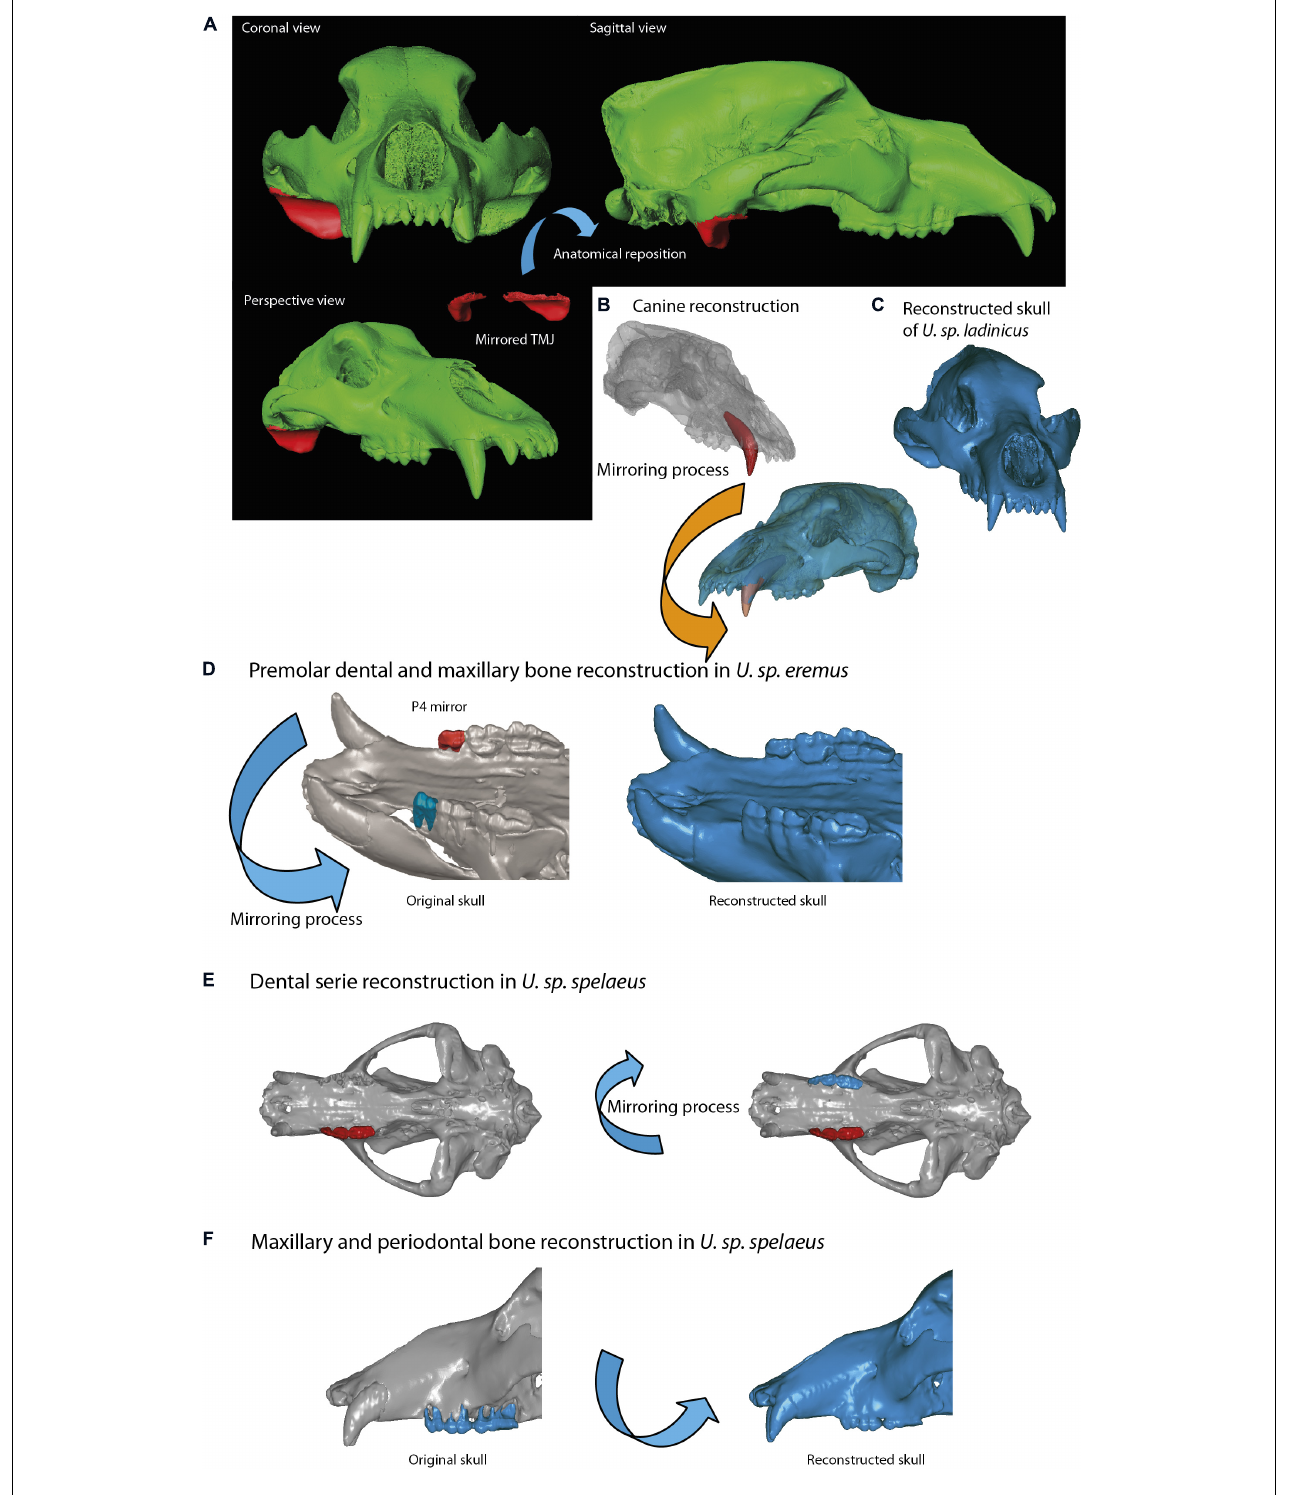
FIGURE 9 | Skull reconstruction with implantation of parts. (A–C) Skull of the U. spelaeus ladinicus (PIUW-CU 703); missing parts are restored by mirroring the contralateral part of the skull. (A) Restoration of the right TMJ. (B) Restoration of the left canine. Original bone in green, mirrored part used for restoration in red. (D) Reconstruction of the missing right P4 (blue), using a mirrored version of the existing left P4 (red) in U. sp. eremus . (E) Reconstruction of the missing left dental serie (blue), using a mirrored version of the existing right dental serie (red) in U. sp. eremus . (F) Comparison between the original skull of U. sp. spelaeus (in gray) and the final skull (in blue) with the periodontal region of the maxillary bone reconstructed.